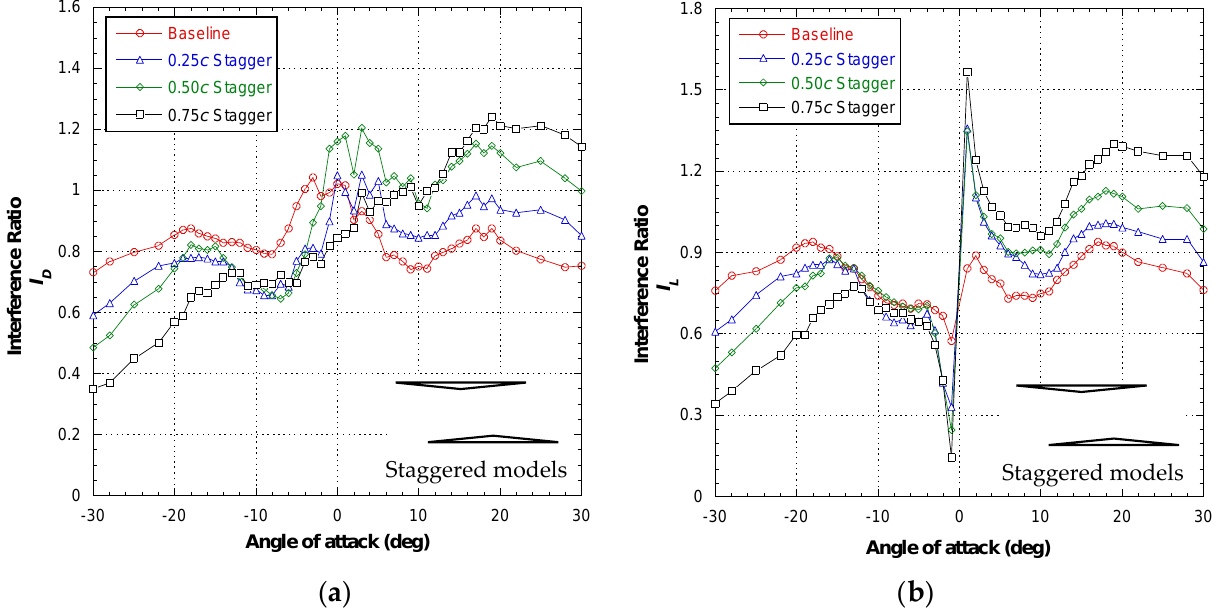
Figure 10. Interference ratios of the biplane aerodynamic forces: ( a ) drag interference ratio; ( b ) lift interference ratio.